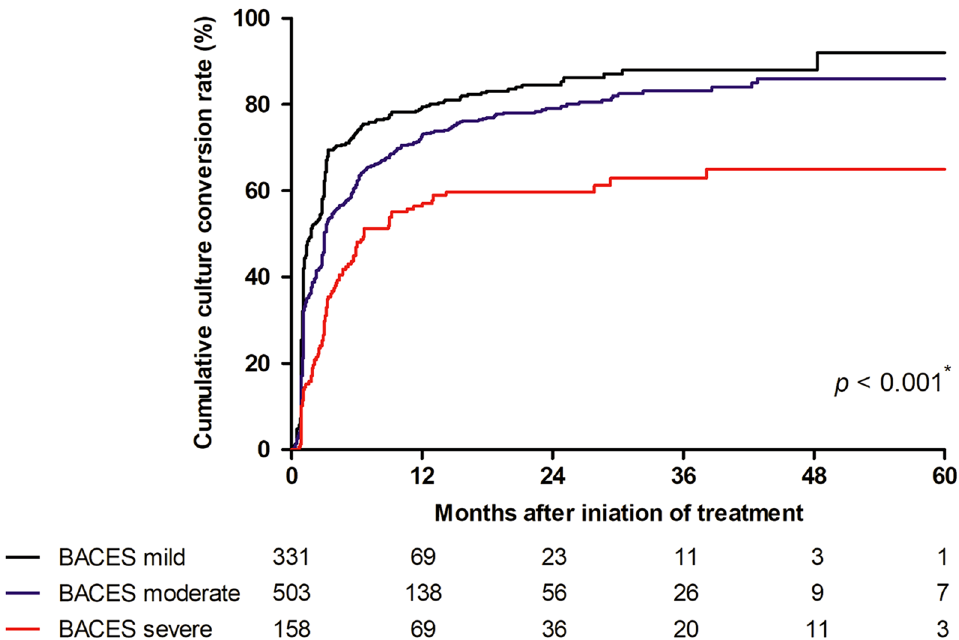
Figure 2. Cumulative culture conversion rate according to BACES severity